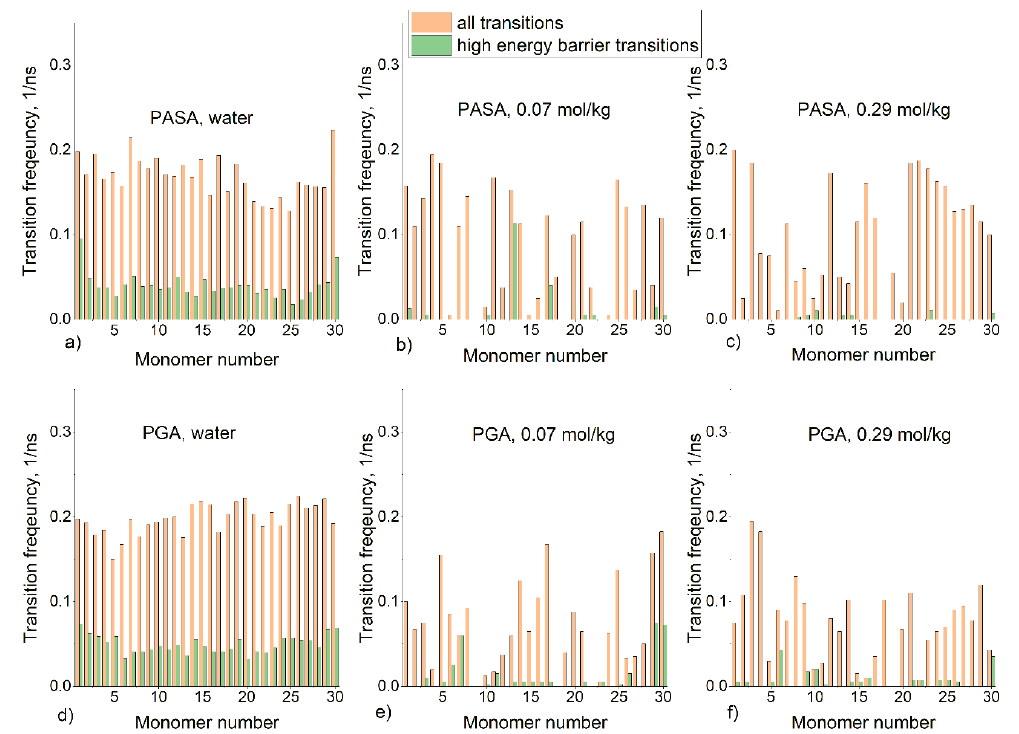
Figure 3. Transition frequencies of the ϕ and ψ dihedral angles for each monomer in the classical unbiased molecular dynamics (MD) simulations. Pink—all transitions, green—transitions through high-energy barriers. ( a ) PASA in water ( b ) PASA in 0.07 mol / kg CaCl 2 solution, ( c ) PASA in 0.29 mol / kg CaCl 2 solution, ( d ) PGA in water ( e ) PGA in 0.07 mol / kg CaCl 2 solution, ( f ) PGA in 0.29 mol / kg CaCl 2 solution.